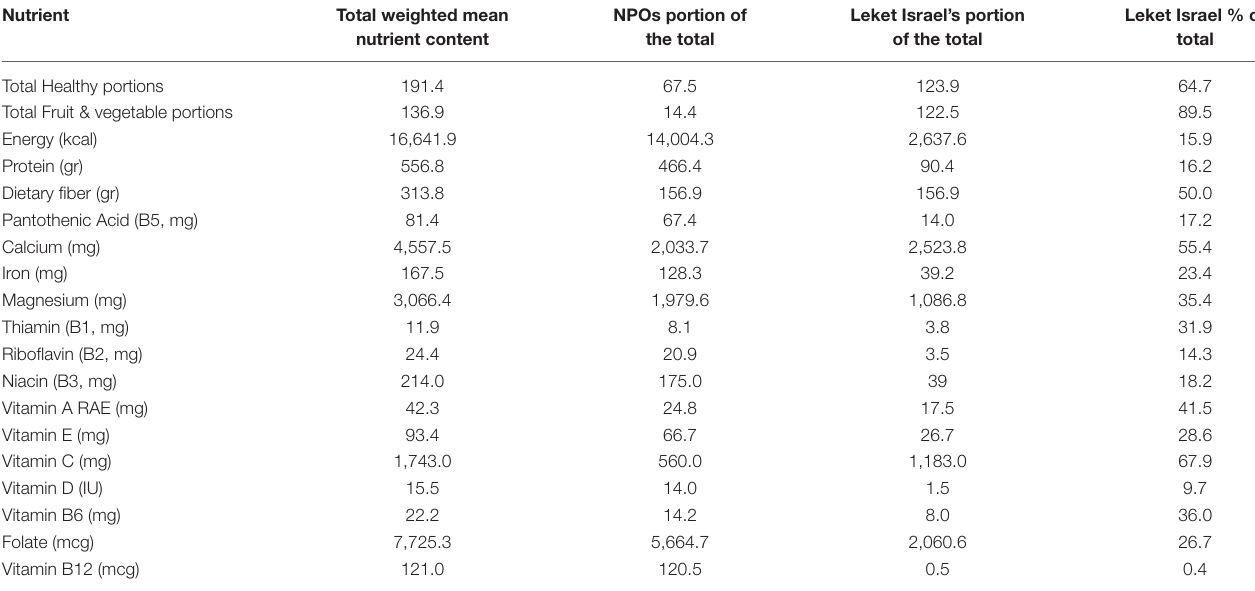
NPOs portion of Leket Israel’s portion nutrient content the total of the